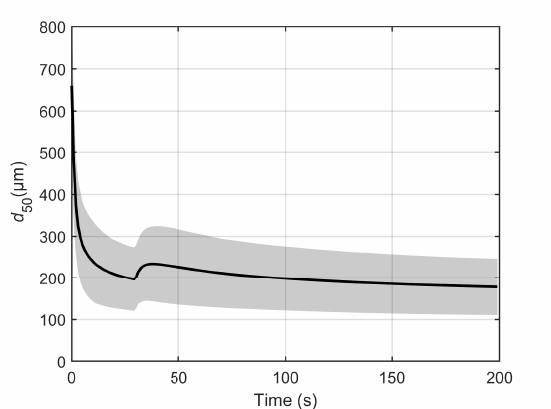
Figure 6. Model prediction (black solid) with 95% confidence range (shaded) using the sigma point method.